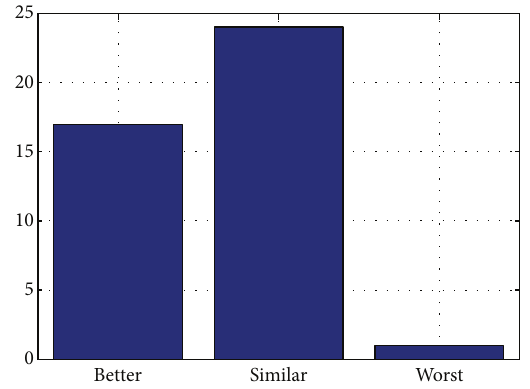
Figure 1: Performance comparison of JADE and HSPEADE1.